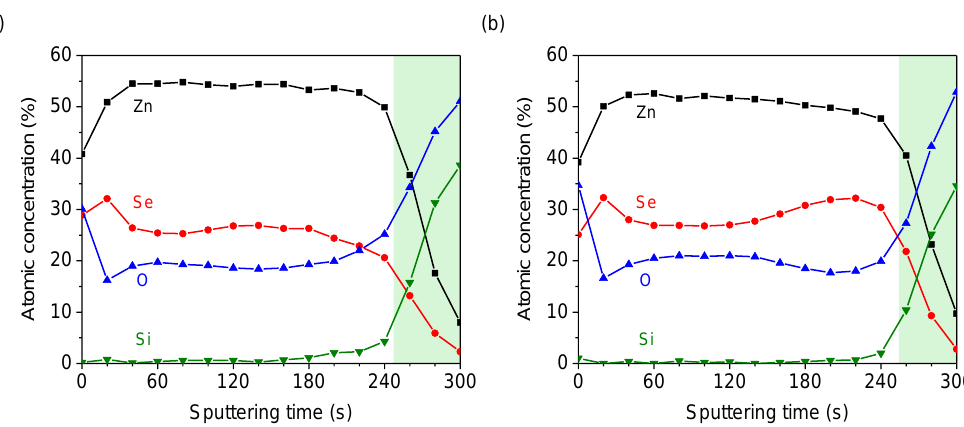
Figure 12. XPS depth profiles of Zn(Se,OH) films ( a ) deposited with selenourea concentration of 0.03 M and the ammonia concentration of 1.2 M, and ( b ) deposited with selenourea concentration of 0.045 M and the ammonia concentration of 1.4 M.